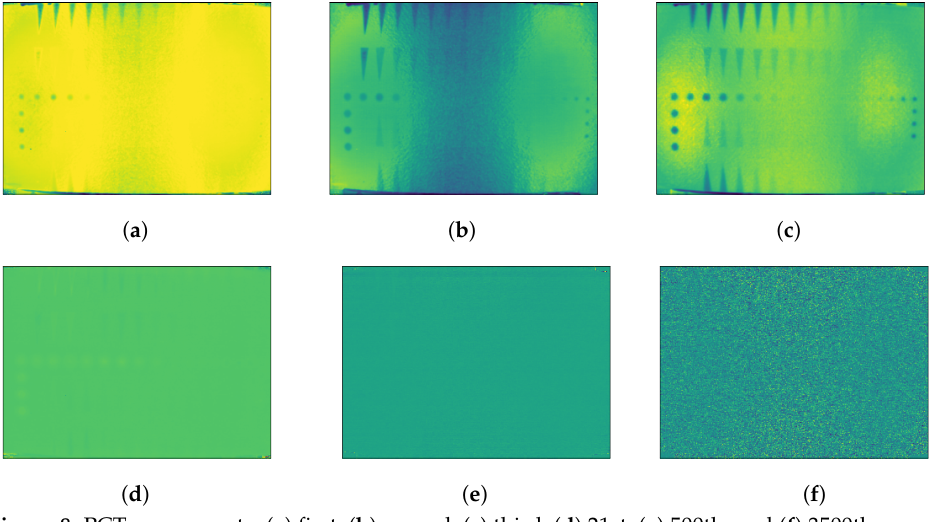
Figure 8. PCT components: ( a ) first; ( b ) second; ( c ) third; ( d ) 21st; ( e ) 500th; and ( f ) 3500th.